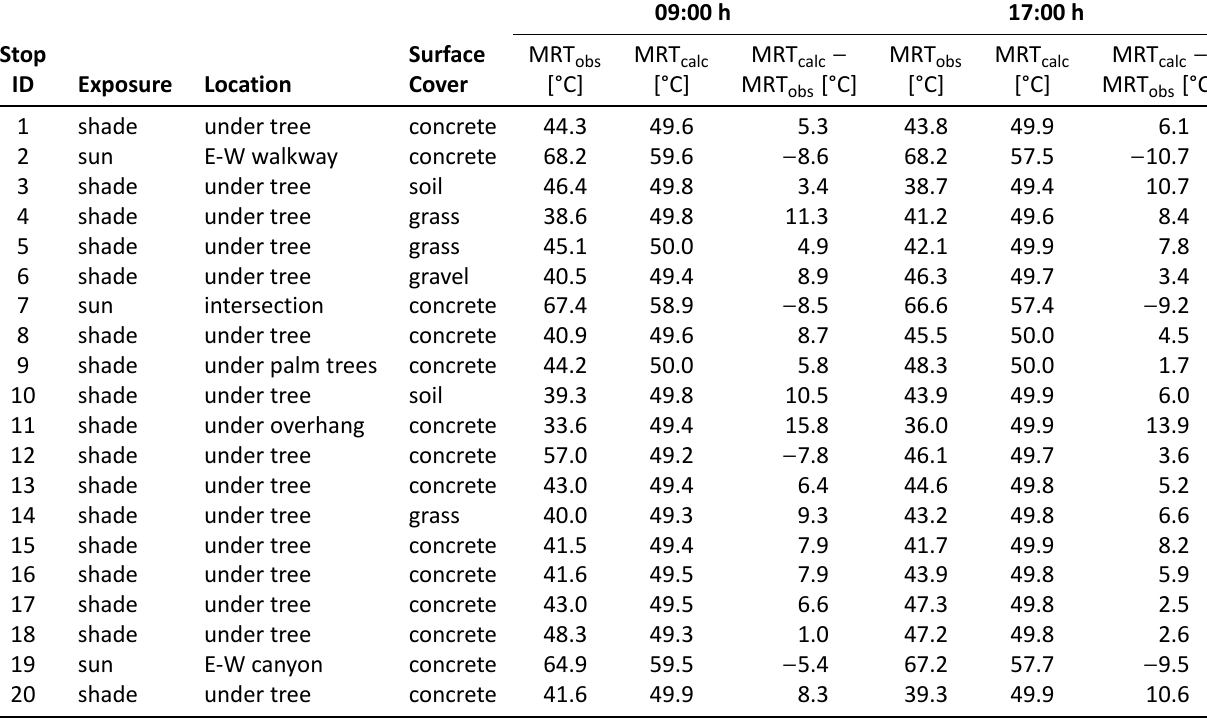
Table 2. Site description and comparison of simulated vs. observed mean radiant temperature for 20 locations in the study area for August 7, 2016 at 9:00h and